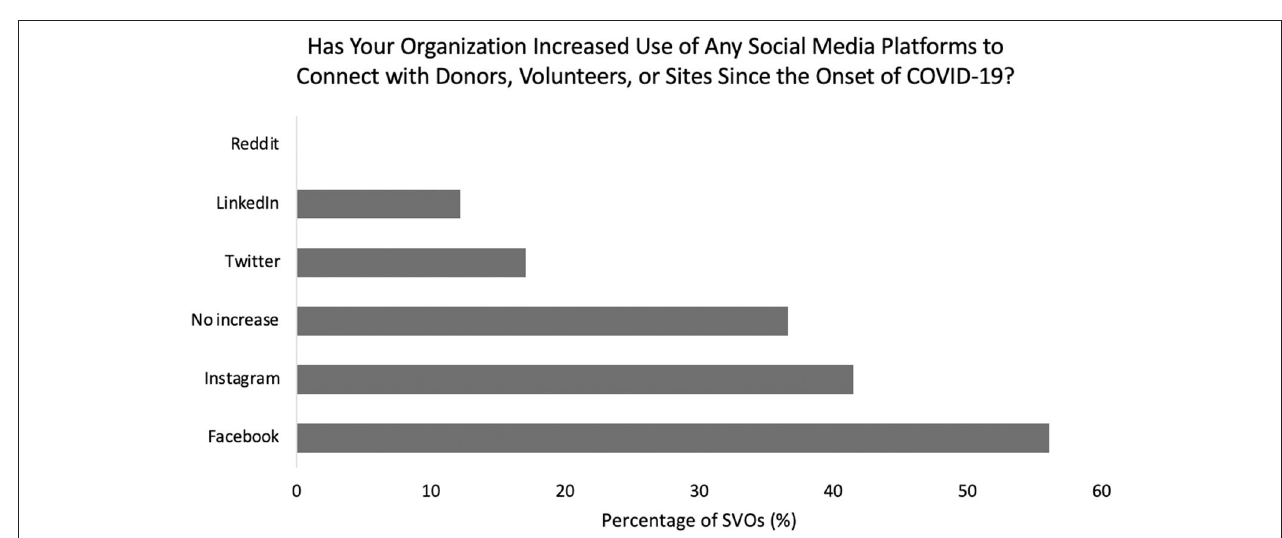
FIGURE 7 | Breakdown of telecommunication platform utilization by surgical volunteer organizations during the pandemic.